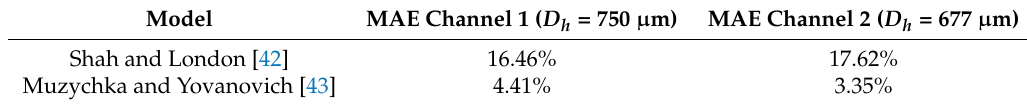
Figure 6. Single phase pressure drop. Shah and London model from [42] and Muzychka and Yovanovich model from [43]. ( a ) Fanning friction of channel with 1.050 mm ˆ 0.5 mm cross section. ( b ) pressure drop of channel with 1.050 mm ˆ 0.5 mm cross section compared with predictive models. ( c ) Fanning friction of channel with 1.500 mm ˆ 0.5 mm cross section. ( d ) pressure drop of channel with 1.500 mm ˆ 0.5 mm cross section compared with predictive models. Table 2. Single phase pressure drop mean absolute error with prediction